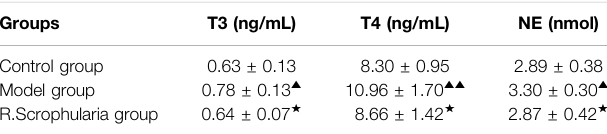
TABLE 1 | Effects of Radix Scrophulariae extract on T3, T4 and NE in hyperthyroidism model rats ( x ± s, n (cid:1) 10). Groups